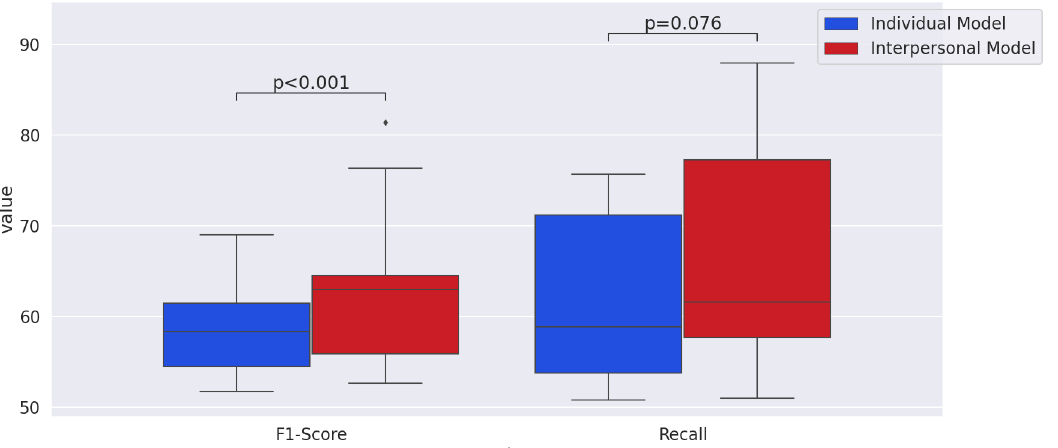
Figure 9. Comparison of the performance metrics between the individual and interpersonal models in the supplemen- tary